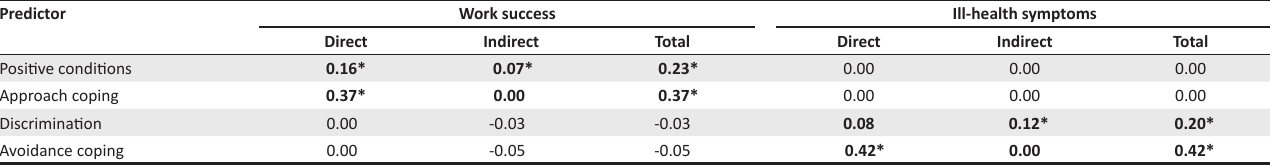
TABLE 3: Mediation effects of integration demands in the workplace (standardised effects). Predictor